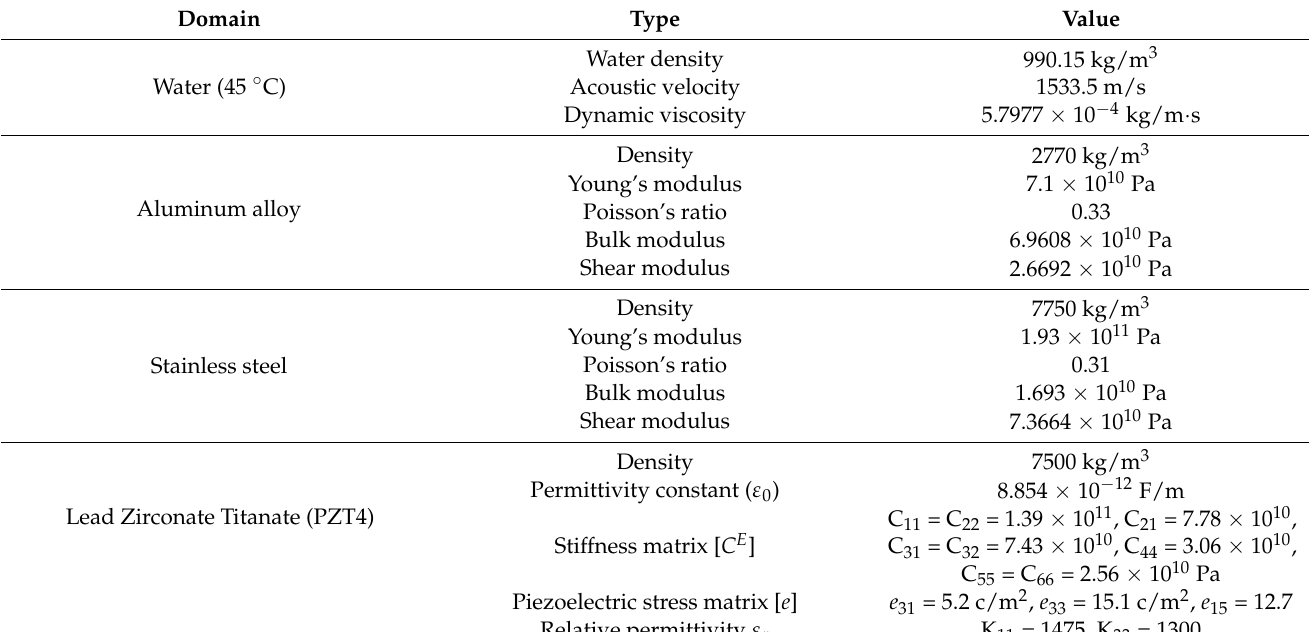
Table 1. Material properties